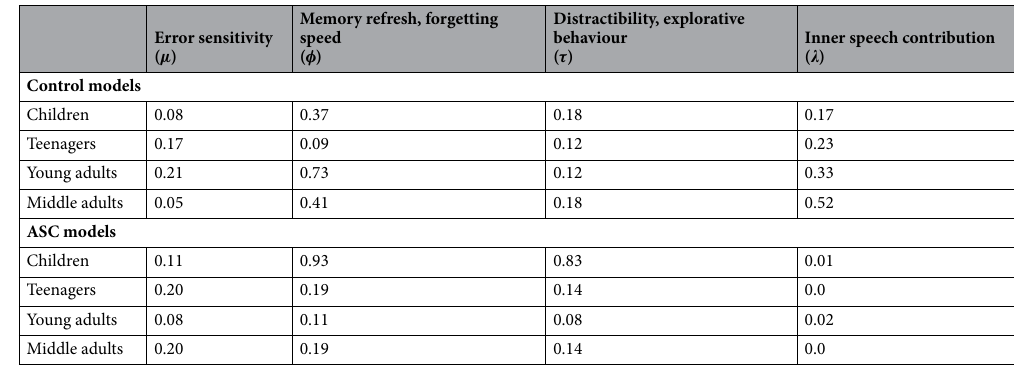
Table 2. Values of the parameters of the models that produce the best fit of the data on the WCST indices.